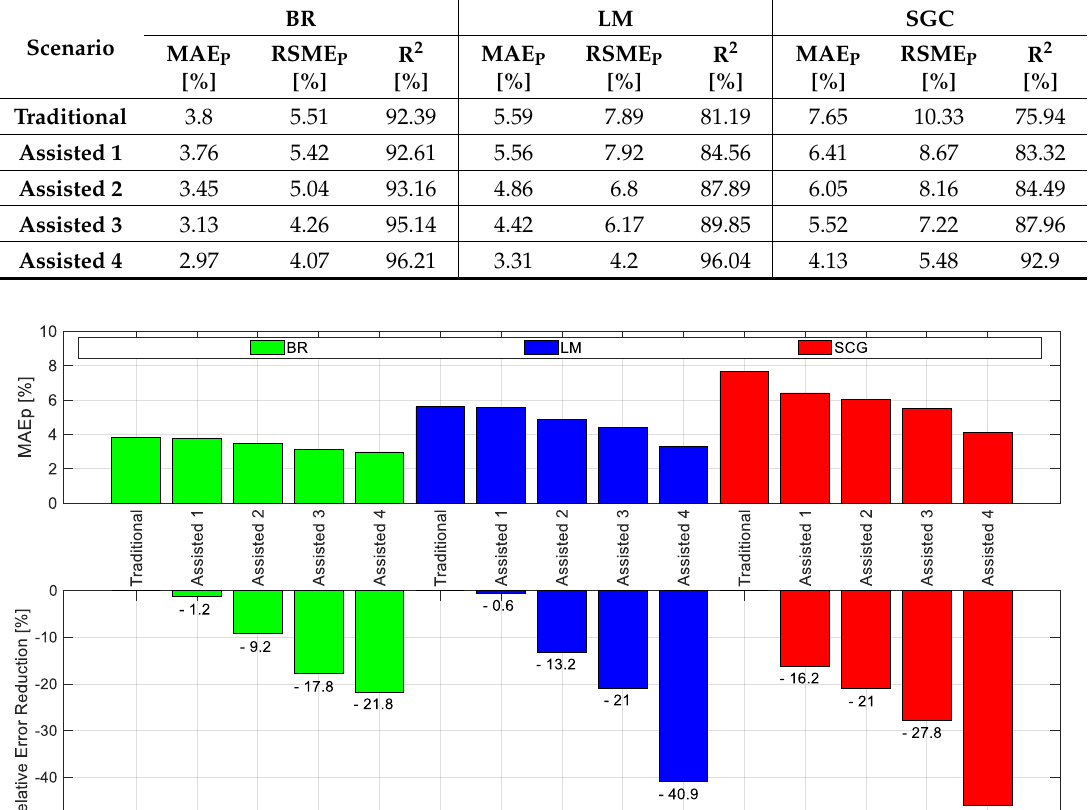
Table 2. Performance metrics for each learning algorithm using the traditional and assisted ANN modeling approaches (averages for the 80 random combinations of the testing dataset).